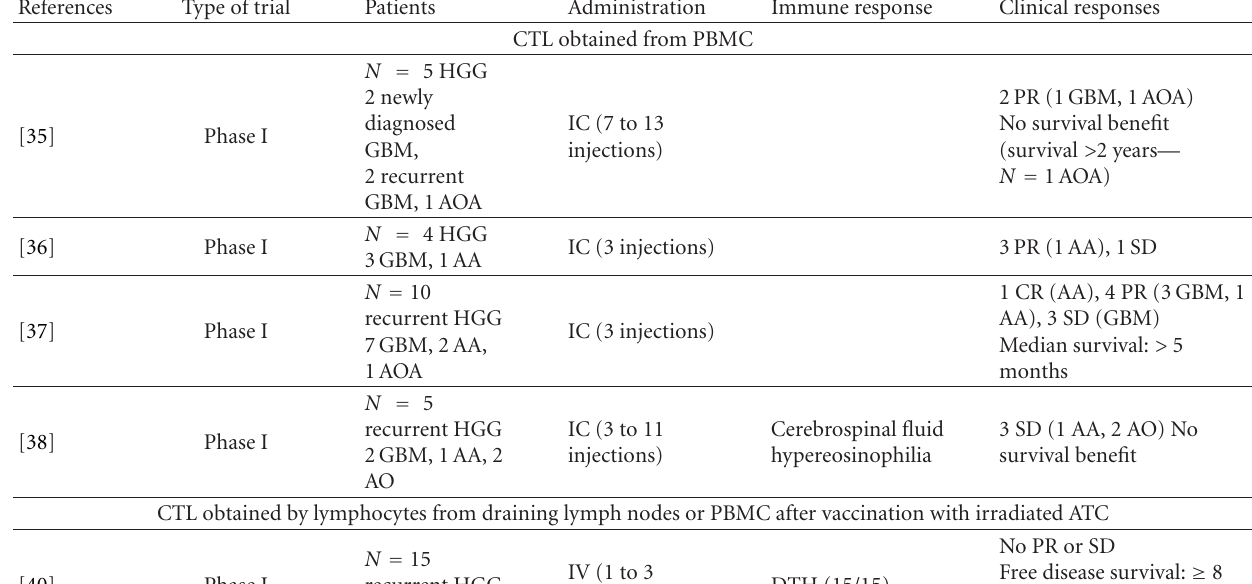
Table 2: Adoptive immunotherapy in high-grade gliomas using cytotoxic T lymphocytes (CTL) or tumour-infiltrated lymphocytes (TIL) ∗ .